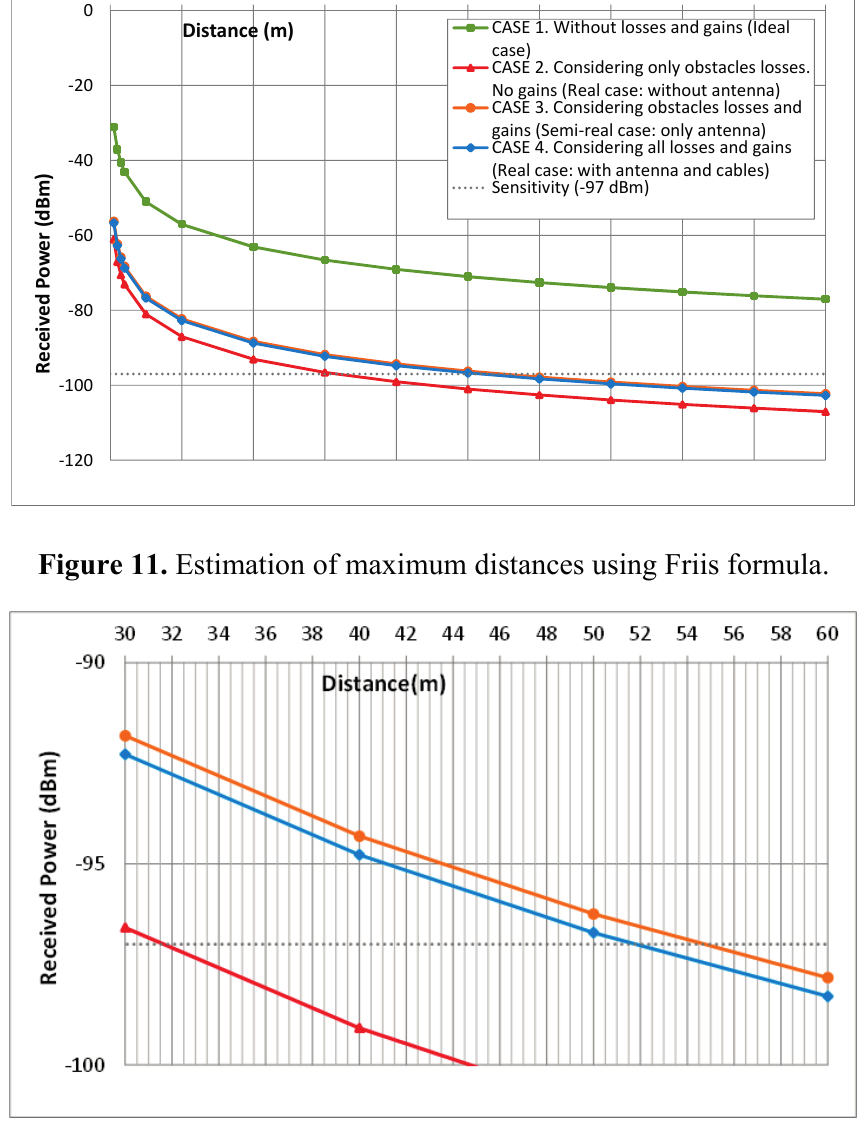
Figure 12. Zoom of maximum distances